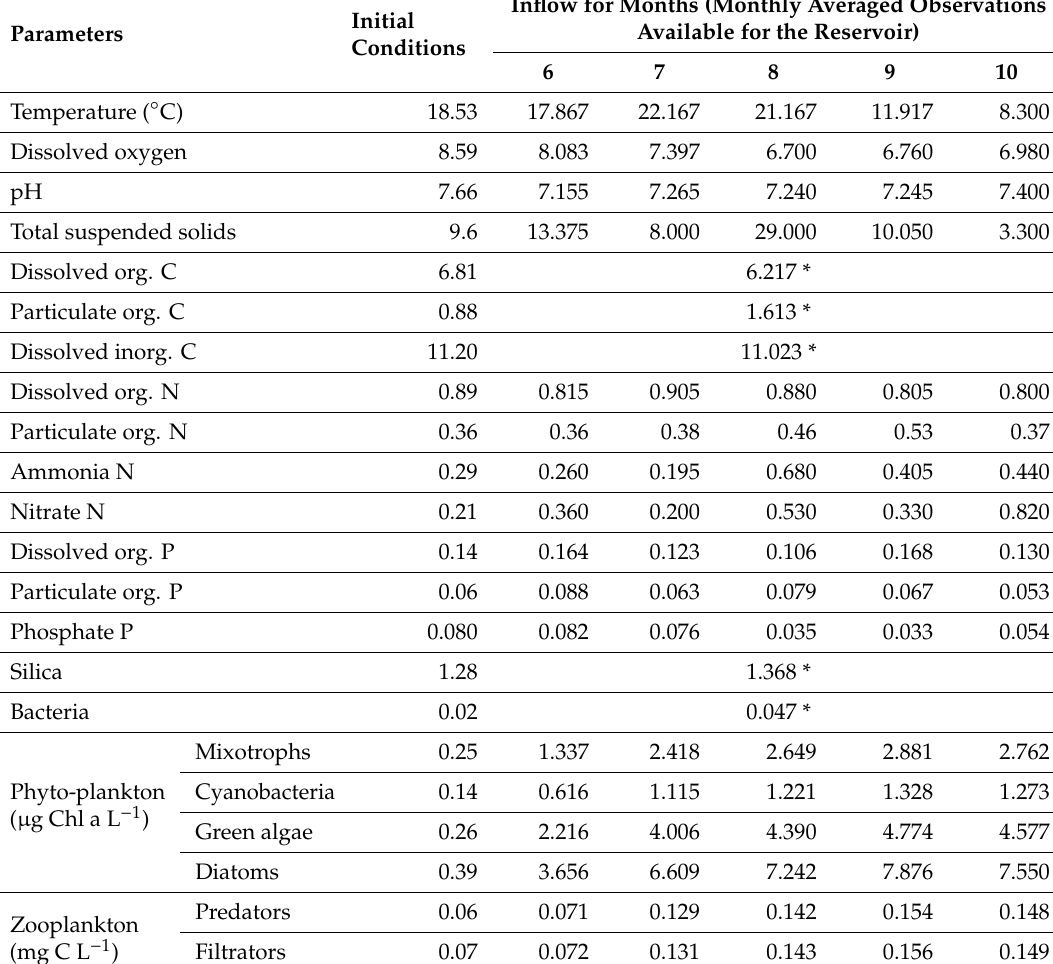
Table 2. Input data regarding the inflow and initial conditions in the Paprocany reservoir (units are mg L − 1 unless otherwise